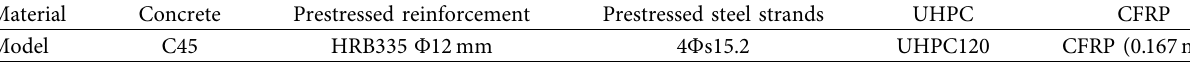
Table 1: Material list.